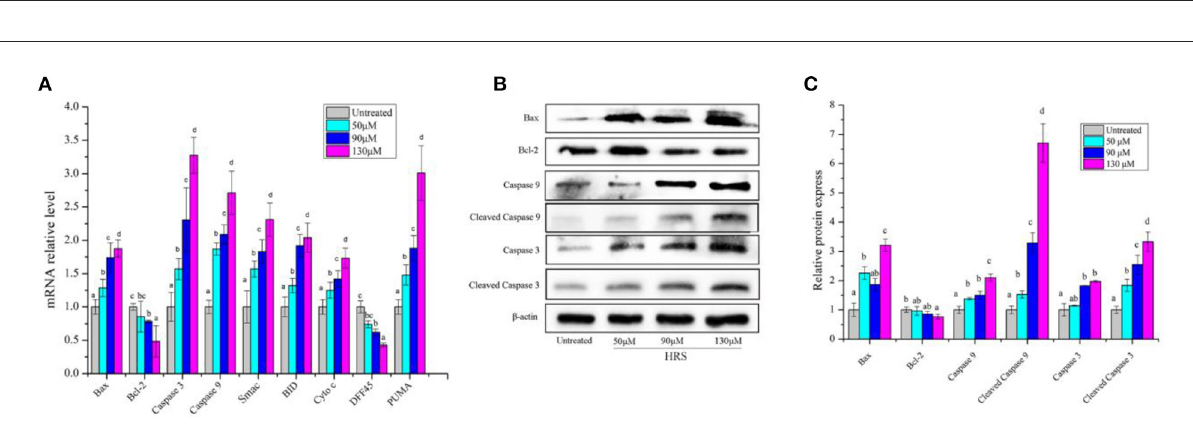
FIGURE8 The mRNA and protein expressions of mitochondrial pathway in HCT-116 cells treated with hydroxy- γ -sanshool (HRS). (A) The mRNA level of mitochondrial pathway related genes. (B) Effects of HRS on related proteins in HCT-116 cells. (C) Levels of mitochondrial pathway related proteins. HCT-116 cells were treated with HRS at designated concentrations and compared to untreated cells. All data were expressed as means ± SD from three replicated experiments. a − d Within a cluster, columns without a common superscript differed ( p <